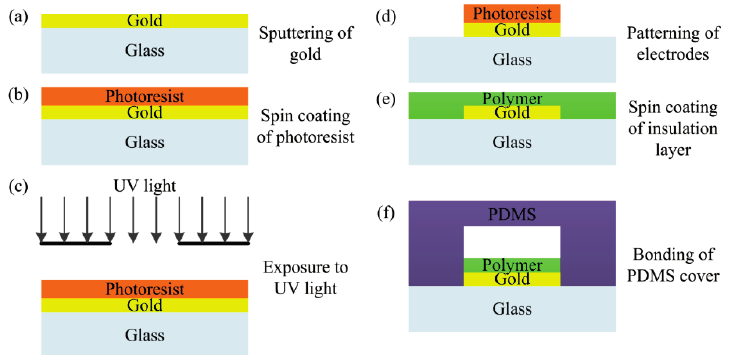
Figure 3. Microfabrication process flow: ( a ) Sputtering of gold on glass substrate; ( b ) Spin coating of photoresist on top of the gold film; ( c ) Exposure to UV light; ( d ) Patterning of gold electrodes; ( e ) Spin coating of insulation layer; ( f ) Bonding of PDMS cap to the processed